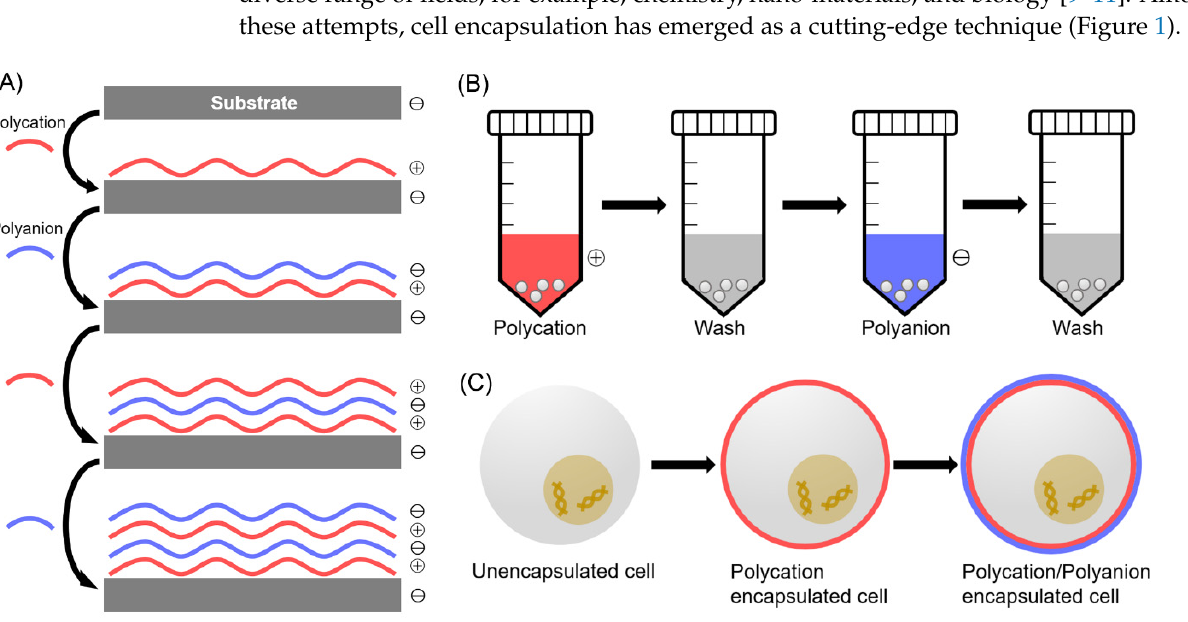
Figure 1. Scheme of the LbL cell encapsulation. ( A ) Negatively charged substrate is incubated with polycation and polyanion alternatively to stack polyelectrolyte films on the substrate based on the electrostatic force. ( B ) Cells in a centrifuge tube are incubated with polycation, followed by centrifuge and washing with buffer solution. Polyanion is then introduced in the same way. ( C ) Cell surface is modified with multilayers using LbL self-assembly.